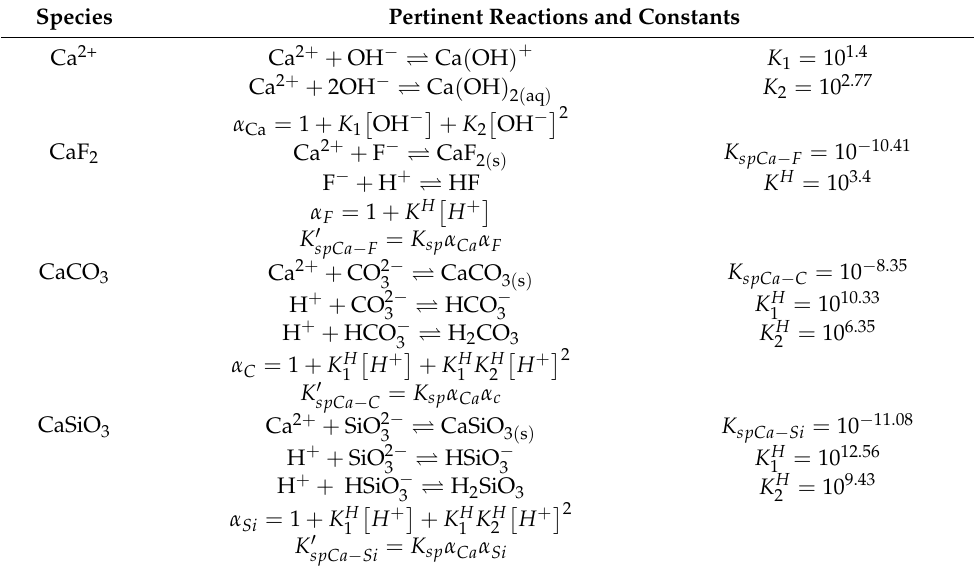
Table 3. Pertinent reactions and thermodynamic data for calculating the conditional solubility products of CaF 2 , CaCO 3 , and CaSiO 3 .